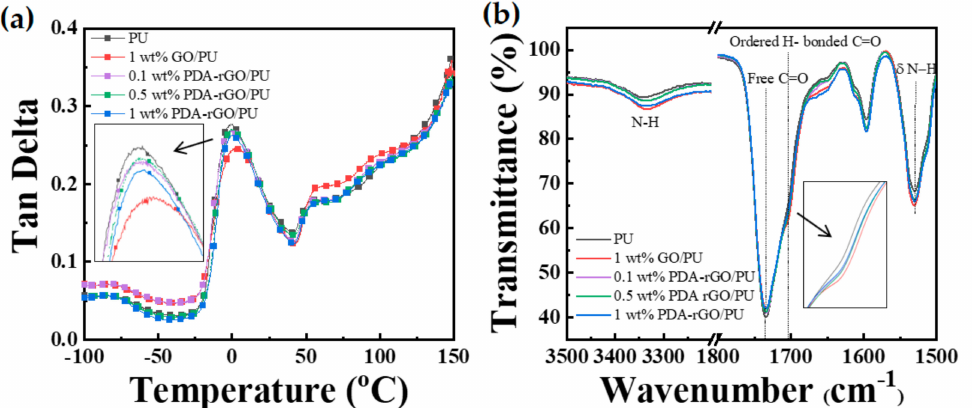
Figure 5. ( a ) Tan delta curves measured by dynamic mechanical analyzer (DMA) and ( b ) FTIR spectra of neat PU and its nanocomposites with 1 wt% of GO and 0.1, 0.5 and 1 wt% of PDA–rGO.